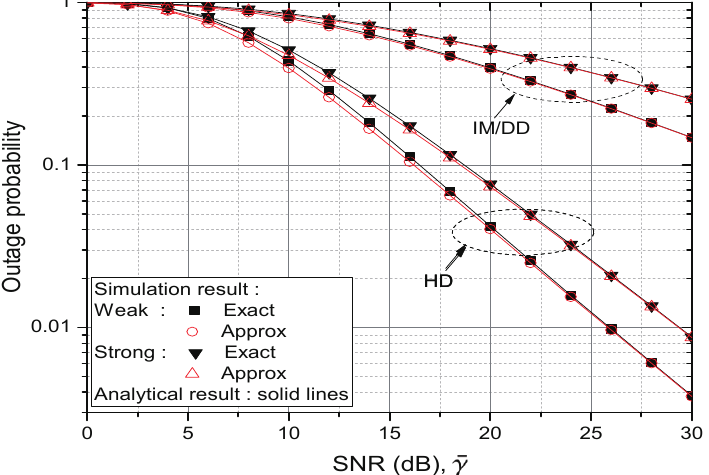
Figure 2. Comparison of CDFs (equivalently, OP) from γ e and γ a ; δ = 1 under weak or strong turbulence,